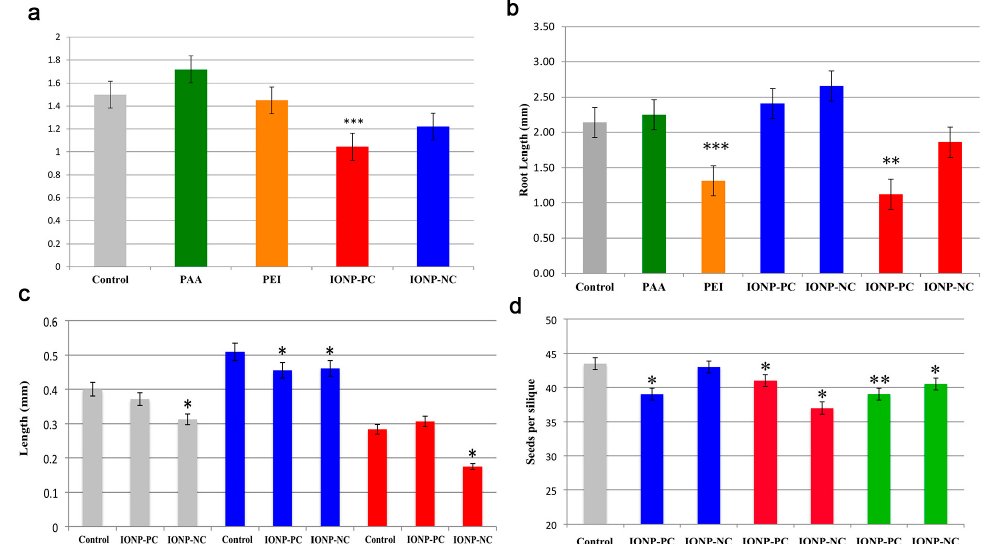
Figure 7. ( a ) Effect of IONP treatment on overall seedling length in A. thaliana . Treatments marked with asterisks were significantly different from the control with p < 0.0001 ( b ) Changes in A. thaliana seedling root length after exposure to IONPs. Treatments with significant difference of p < 0.009 are marked with two asterisks; p < 0.0001 are marked with three asterisks. ( c ) Effects of IONPs on pollen tube growth in A. thaliana. Treatments with significant differences from the control are marked with an asterisk ( p < 0.05). ( d ) Treatment of A. thaliana with IONPs resulted in reduced seed production. Single asterisks represent treatments that were significantly different from the control with a p < 0.05; two asterisks indicate treatments that were significantly different with a p < 0.01. Reprinted with permission from Ref. [73].